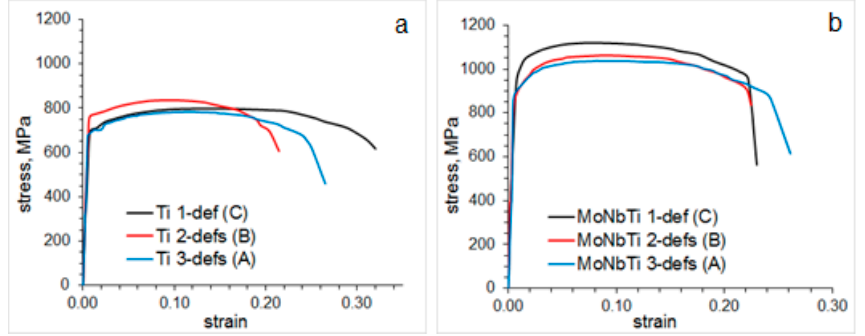
Figure 12. Ambient temperature stress ‐ strain curves for ( a ) Ti ‐ steel and ( b ) MoNbTi ‐ steel. Table 2. Mechanical properties in the studied steels.